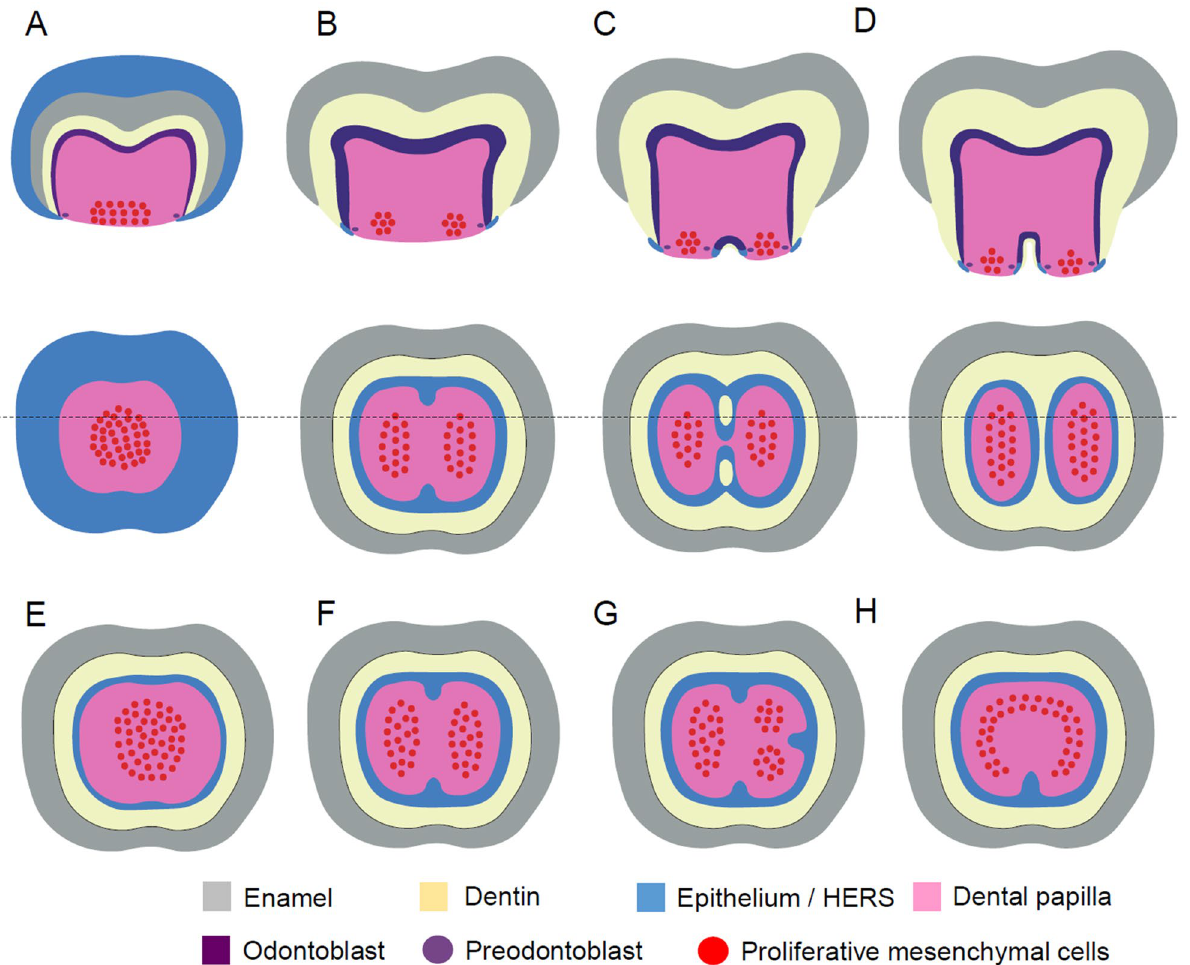
Figure 3. Schema of tooth root bifurcation. ( A – D ) Sagittal section and axial view of a developing human tooth at the stage of crown development ( A ) and at the stages of root development; before root bifurcation ( B ), during the dentin island formation ( C ), and after root bifurcation ( D ). The broken line denotes the sagittal section of the tooth. ( E – H ) Axial view of a developing tooth with one root ( E ), two roots ( F ), three roots ( G ), or a C-shaped root ( H ). The illustrations were created using Adobe Illustrator ver